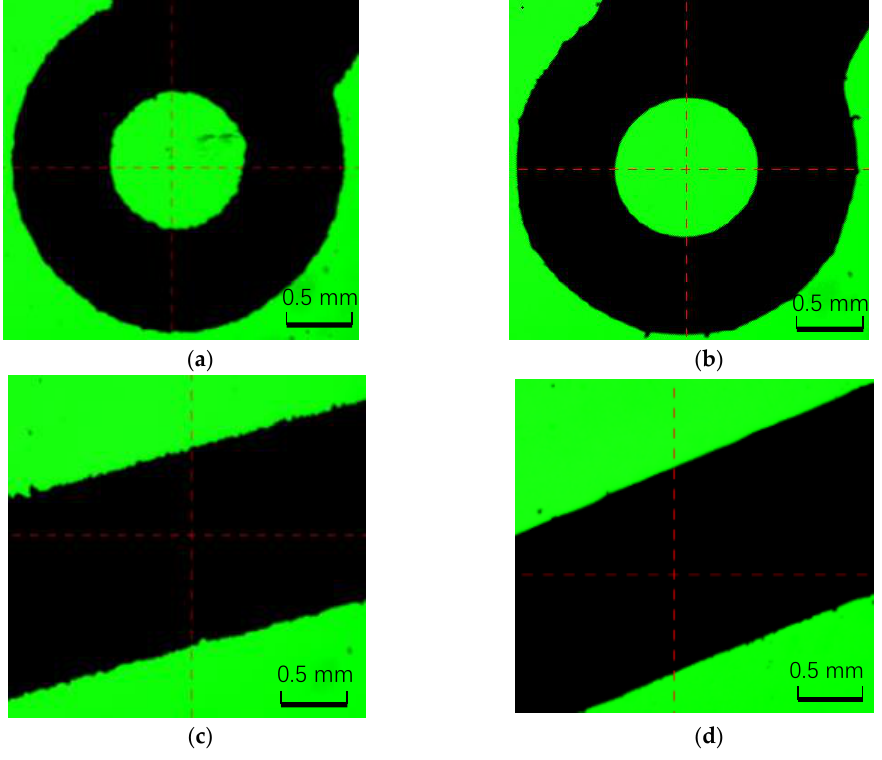
Figure 9. A ring of a leaf spring using ( a ) wire-EDM, ( b ) etching and a line of a leaf spring using, ( c ) wire-EDM and ( d ) etching. Table 9. Results of error in roundness.